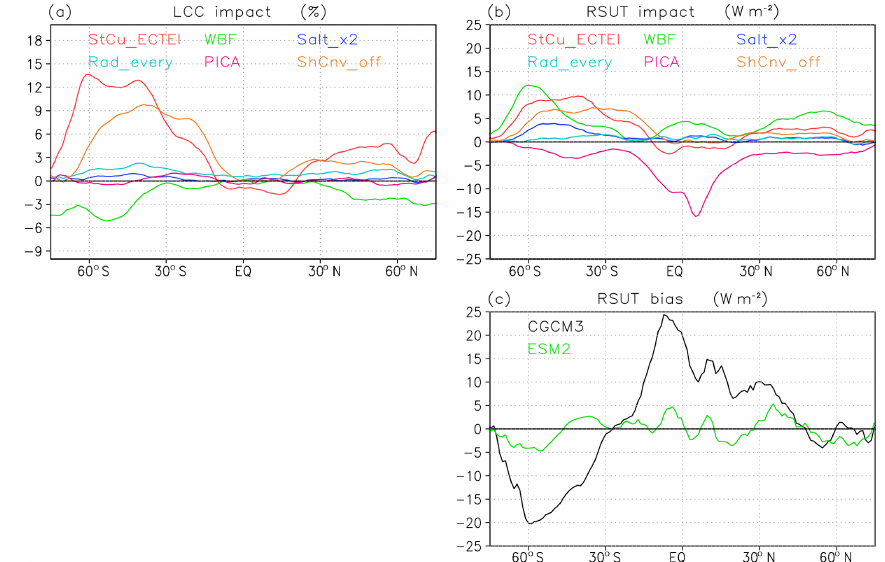
Figure 11. Impacts of each modification on zonal means of (a) low-cloud cover (%) and (b) TOA upward shortwave radiative flux (Wm − ). Modifications include a new stratocumulus scheme (red line), the new treatment of the WBF effect (green), doubled number concentration of sea salt CCN (blue), increased horizontal resolution for radiation calculation (light blue), a new cloud overlap scheme, PICA (pink), and a treatment of shallow convection suppressed under stratocumulus conditions (orange). Each impact is calculated from the simulation data described in Sect. 2.3. The biases in TOA upward shortwave radiative flux for MRI-CGCM3 (black line) and MRI-ESM2 (green) are also shown in (c) , where the data used are the same as in Fig.